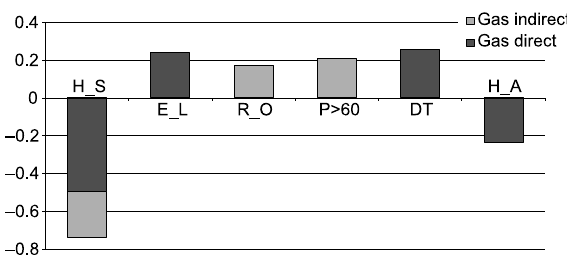
fig. 10. Direct and indirect effect of variables on